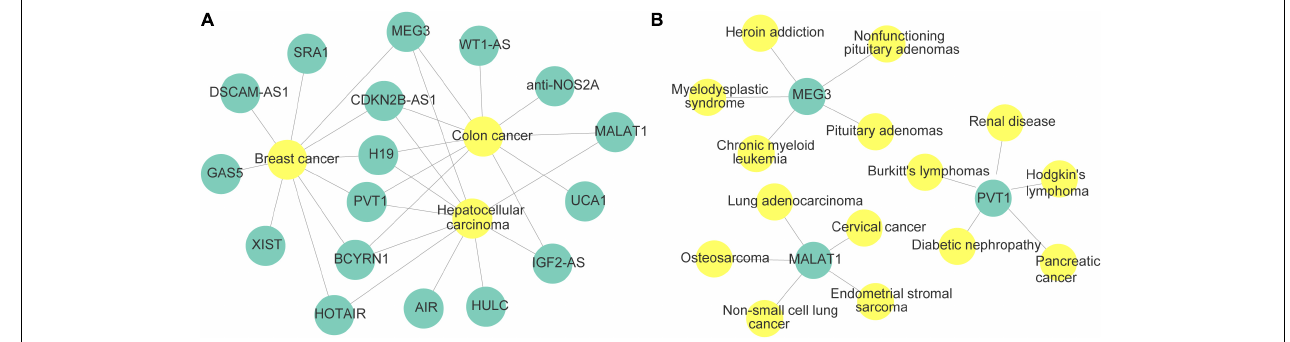
FIGURE 4 | The network of diseases and lncRNAs were made by Cytoscape. (A) The network of novel lncRNAs related to colon cancer, hepatocellular carcinoma, and breast cancer. (B) The network of novel diseases related to lncRNA MALAT1, PVT1, and